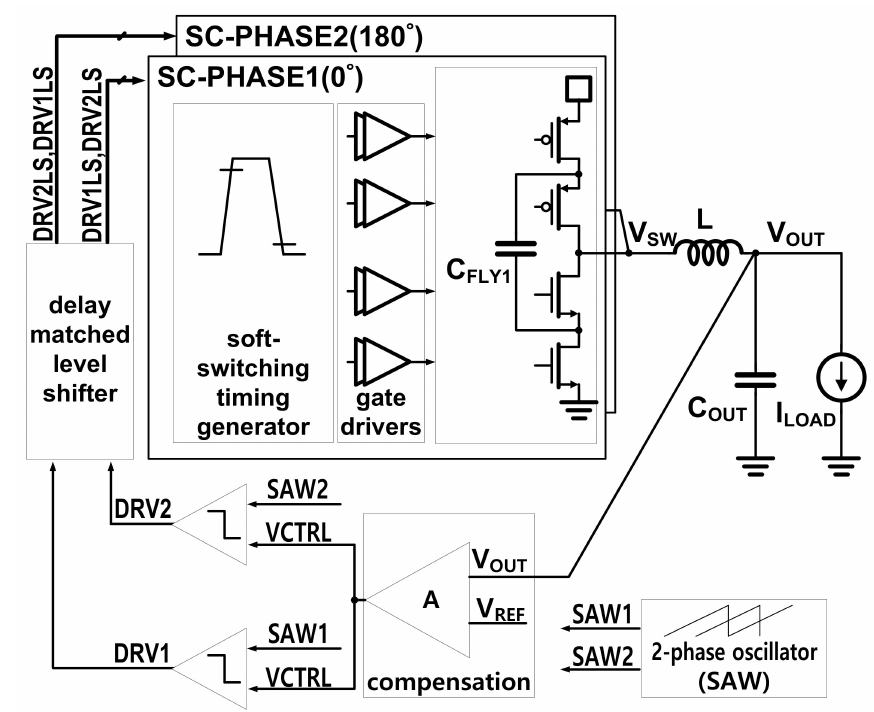
Figure 6. Overall implementation of the proposed soft-switching hybrid DC-DC converter.